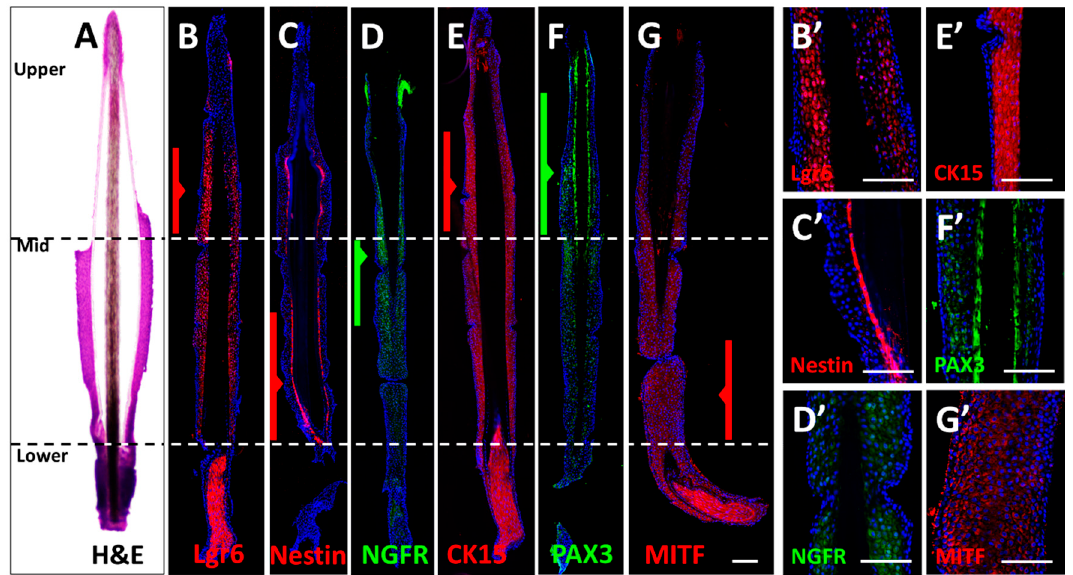
Figure 1. Morphological Expression of biomarkers in the plucked hair follicles. Serial longitudinal sections of plucked hair follicles were stained with H&E ( A ) and labelled immunohistochemically using antibodies for Lgr6 ( B , B’ , red), nestin ( C , C’ , red), NGFR ( D , D’ , green), CK15 ( E , E’ , red), PAX3 ( F , F’, green), MITF ( G , G’ , red). The highest staining intensity was highlighted by broad arrows amid the distal, mid, and proximal portions of the outer root sheath (ORS), which are segmented by dashed lines. The areas with the most prominent signal have been displayed in higher magnification (B’–G’). Magnification: ( A – G ) sutured images, ( B’ – G’ ) 40×; scale bar 100 μ m.